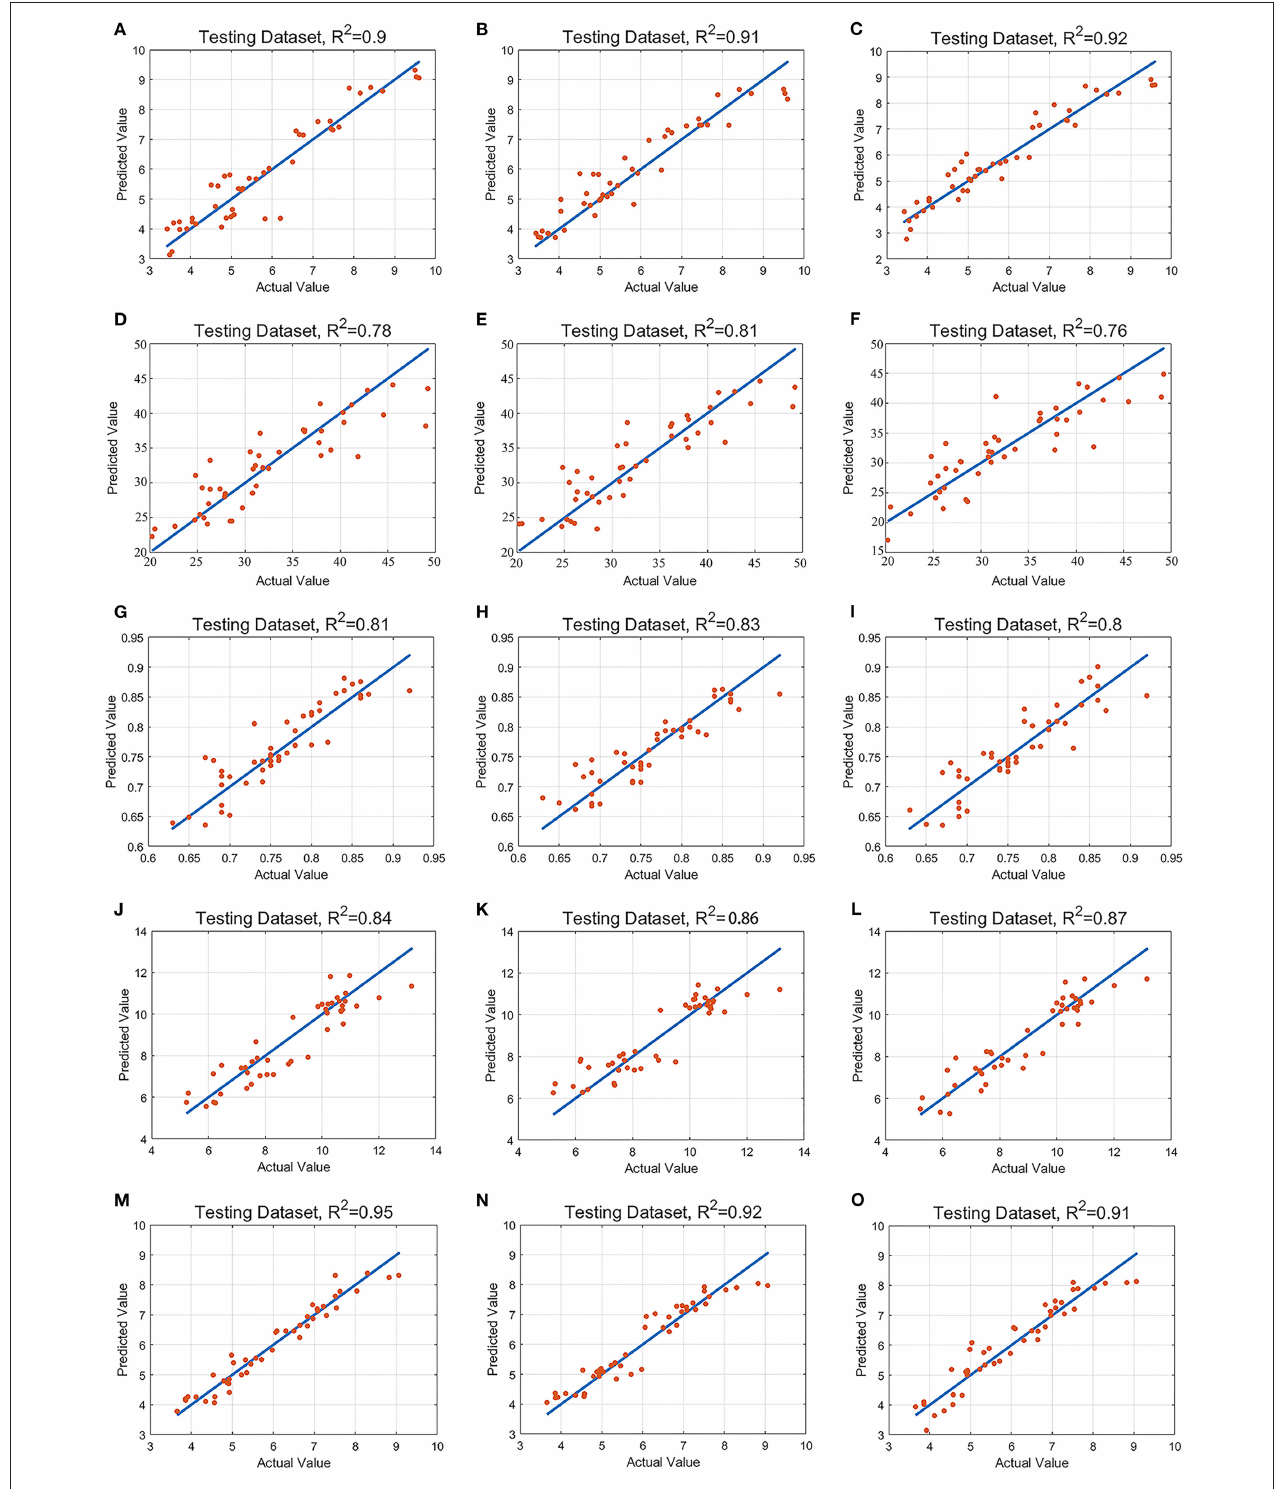
FIGURE 6 | Scatter plot of real and predicted values. (A) . Malondialdehyde-support vector machine; (B) . Malondialdehyde-random forest; (C) . Malondialdehyde-partial least-squares regression; (D) . Electrolyte leakage-support vector machine; (E) . Electrolyte leakage-random forest; (F) . Electrolyte leakage-partial least-squares regression; (G) . Fv/Fm -support vector machine; (H) . Fv/Fm -random forest; (I) . Fv/Fm -partial least-squares regression; (J) . Soluble saccharide-support vector machine; (K) . Soluble saccharide-random forest; (L) . Soluble saccharide-partial least-squares regression; (M) Drought damage degree-support vector machine; (N) . Drought damage degree-random forest; (O) . Drought damage degree-partial least-squares regression.